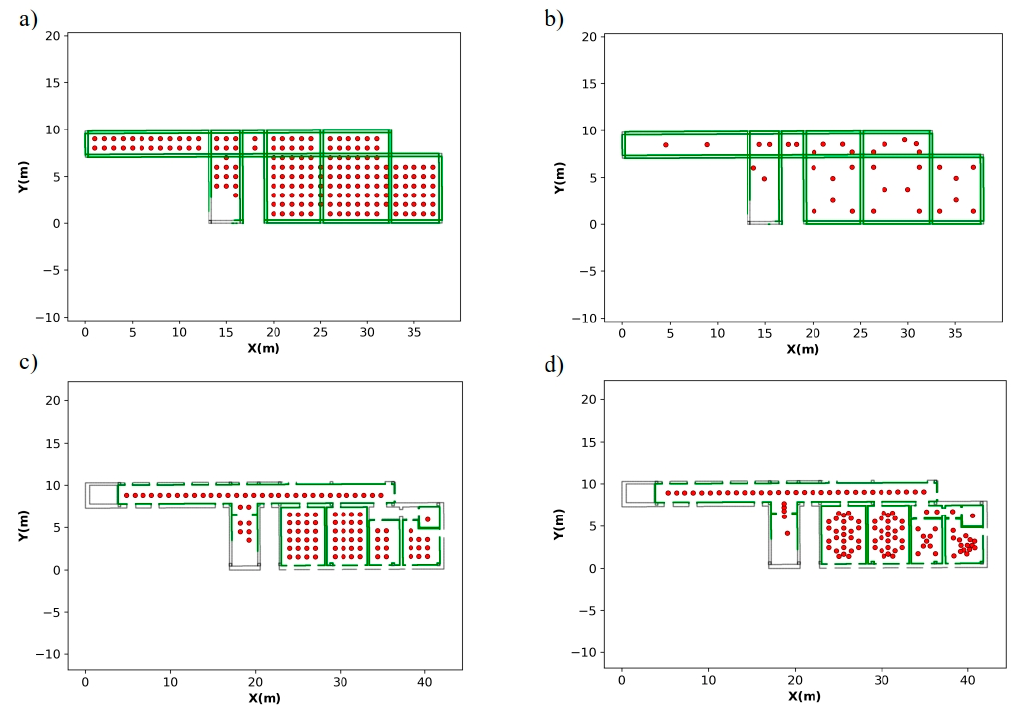
Figure 17. Visibility analysis results obtained from candidates generated in case study 2.